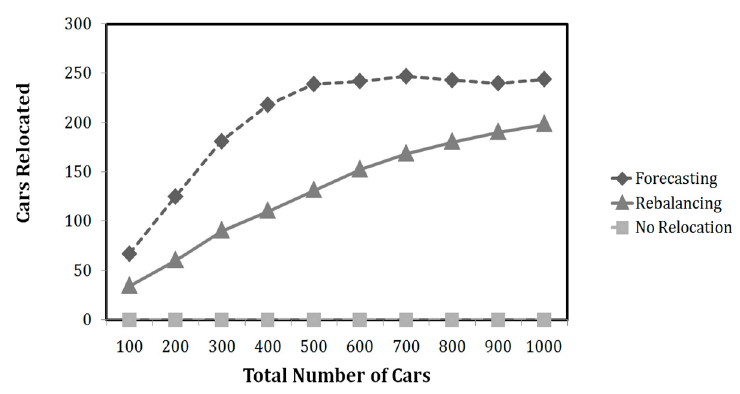
Figure 9. Impact of the number of cars on relocation cost.